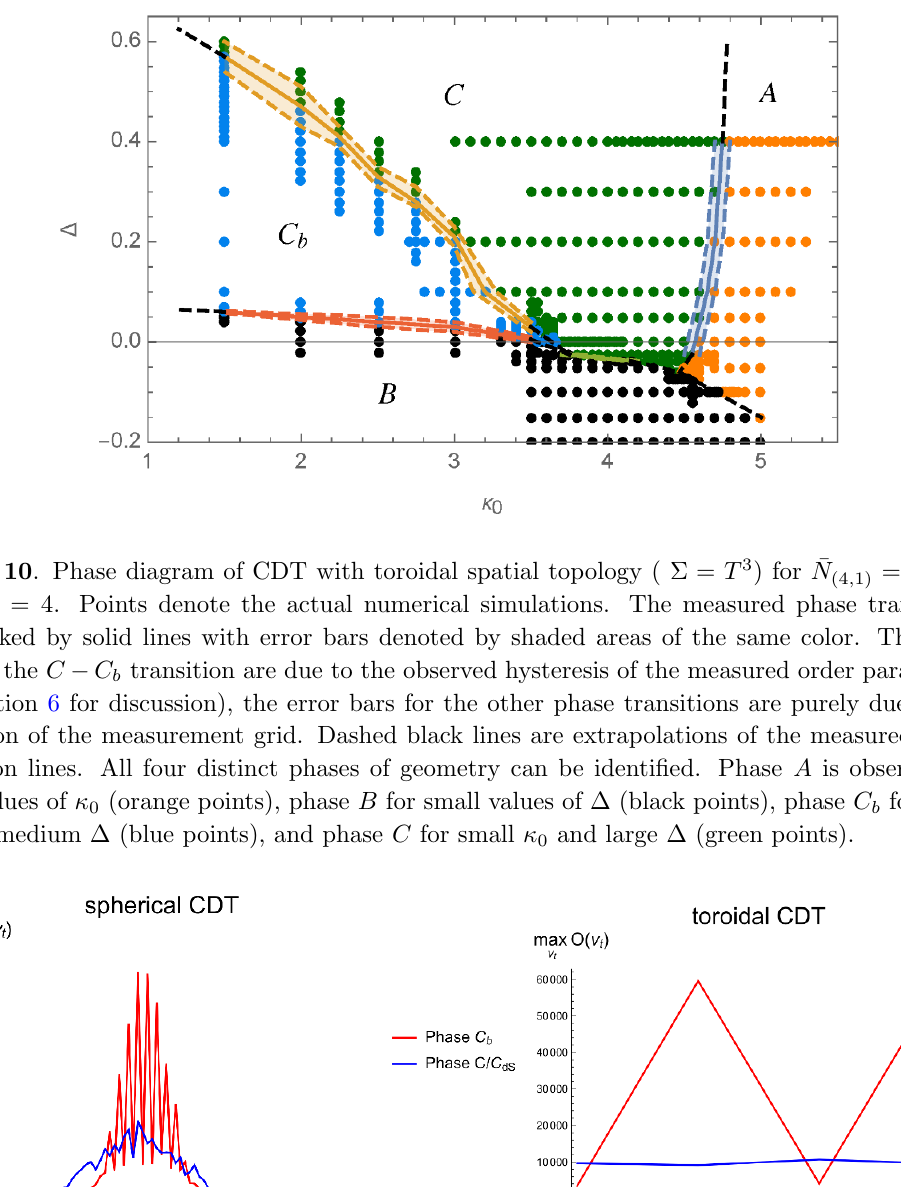
Figure 11 . Time structure of highest order vertices in CDT triangulations with spherical (left plot) and toroidal (right plot) spatial topology. max v the highest order vertex with time coordinate t . Distinction between the bifurcation phase C b with characteristic high order vertices in every second time layer, and phase C=C dS is clear in both